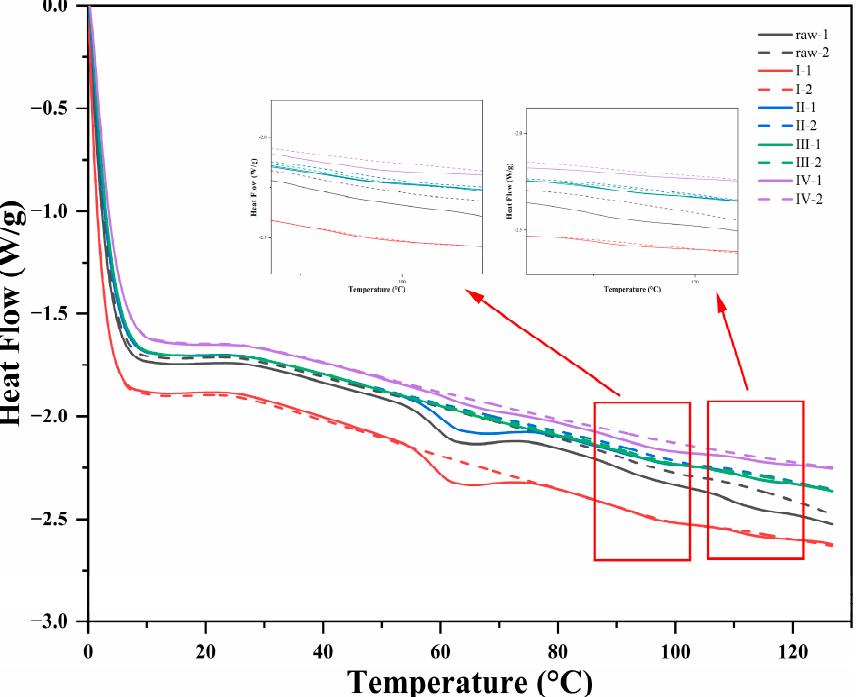
Figure 4. DSC pattern of native oat (raw) in mixing zone (I), cooking zone (II), melting zone (III), and extrudate ( Ⅳ ) for two scans. Solid lines (1): the first scan; Dotted lines (2): the second scan.